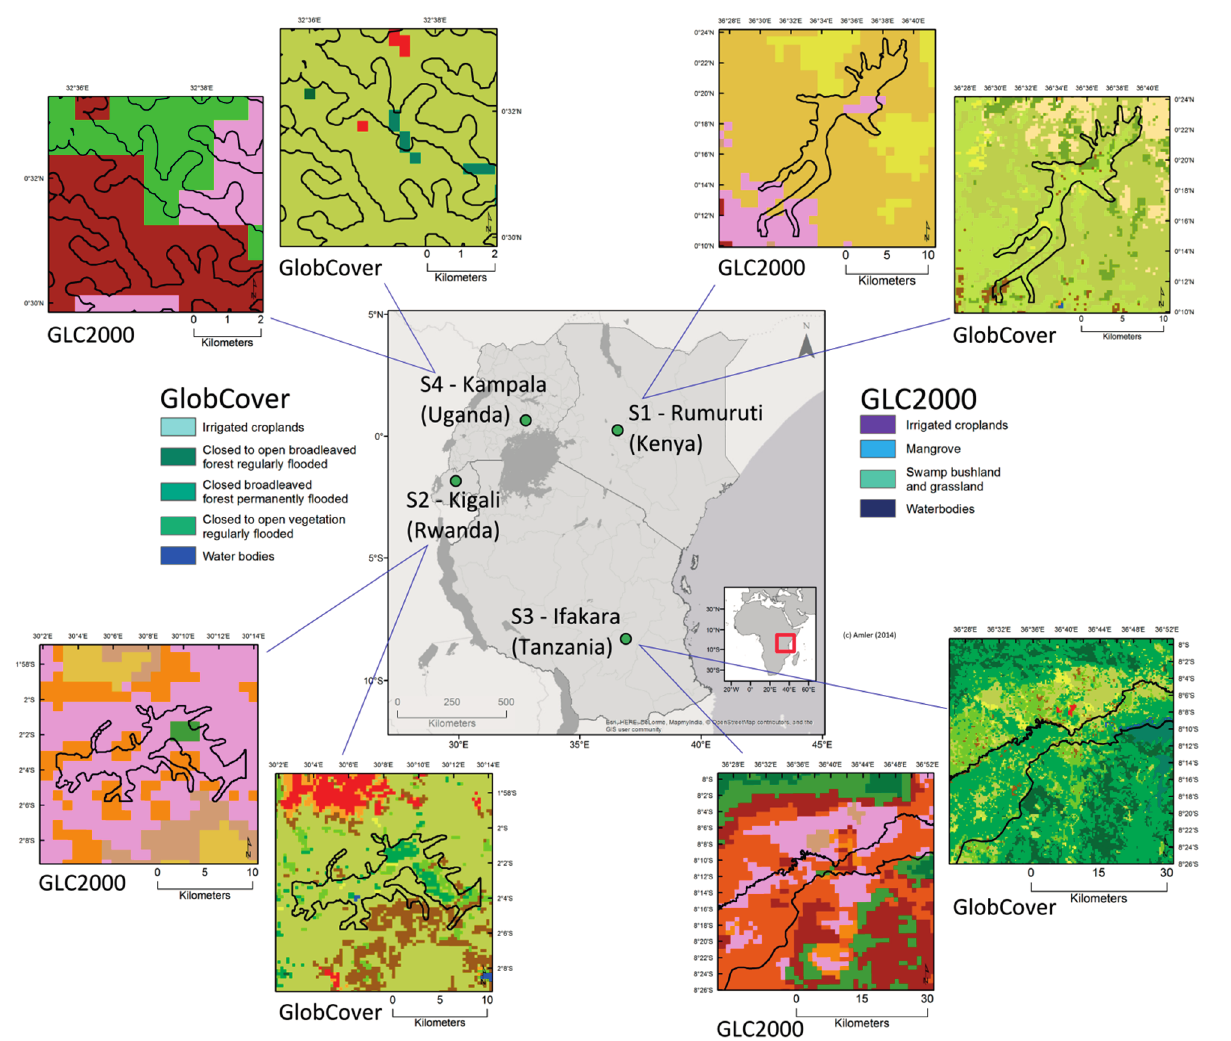
Figure 3. Comparison of the GLC2000 and GlobCover classifications, including wetland test sites. Wetland classes are shown in the legends. The four GlobE Wetlands project test sites are shown as vector overlays on the two LUCs